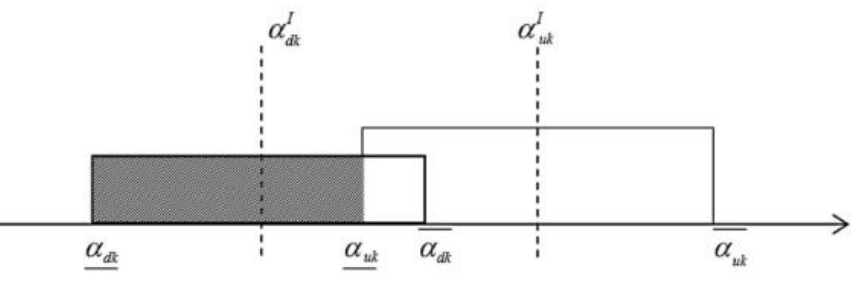
Figure 1. Schematic plot of PODE.